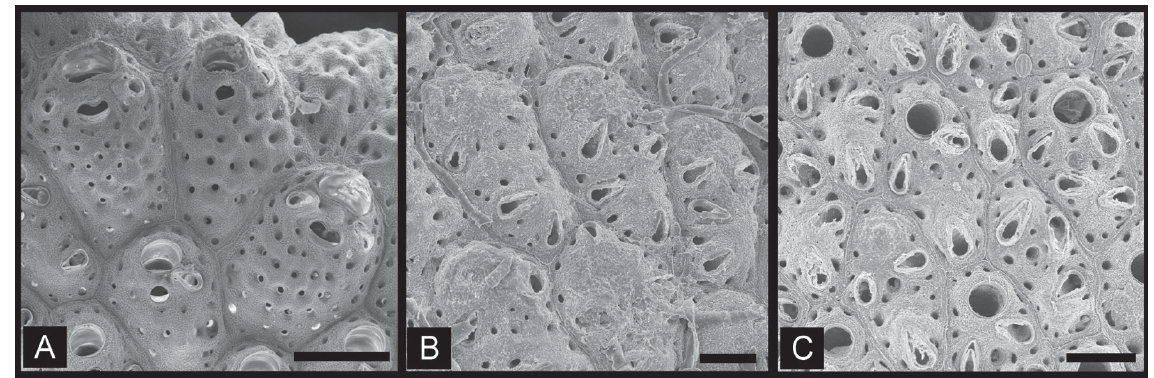
Fig. 3. Adeonella cf. lichenoides (Lamarck, 1816). A . Gonozooids at branch bifurcation (NsMT-Bry r 365, sagami sea). B . Kenozooids with numerous frontal avicularia (NsMT-Bryr360, sagami sea). C . Autozooids with numerous frontal avicularia (NsMT-Tes14, sagami sea). seM images. scale bars: A, C = 200 μm; B = 100